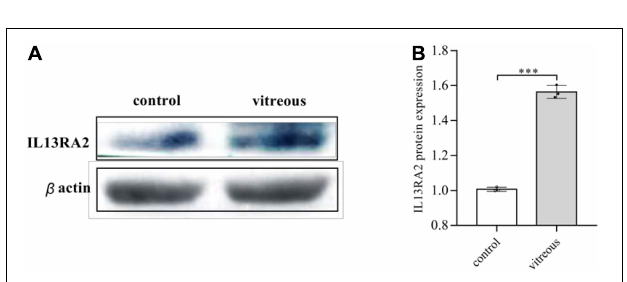
FIGURE 5 | Vitreous induced the protein expression of IL13R α 2. Western blot analysis of the vitreous-induced protein expression of IL13RA2 in ARPE-19 cells. One of three representative experiments is shown. Bar graphs showed the Western blot band intensity, and the mean ± SD of three independent experiments is shown; ∗∗∗ denotes 0.001, using paired t test. (A) The protein expression of IL13RA2 in ARPE-19 cells. (B) Histogram of protein expression gray value. The mean ± SD of three independent experiments is shown; ∗∗∗ denotes 0.001, using paired t test. Control: ARPE-19 cells treated with DMEM/F12 only. Vitreous: ARPE-19 cells treated with vitreous diluted in